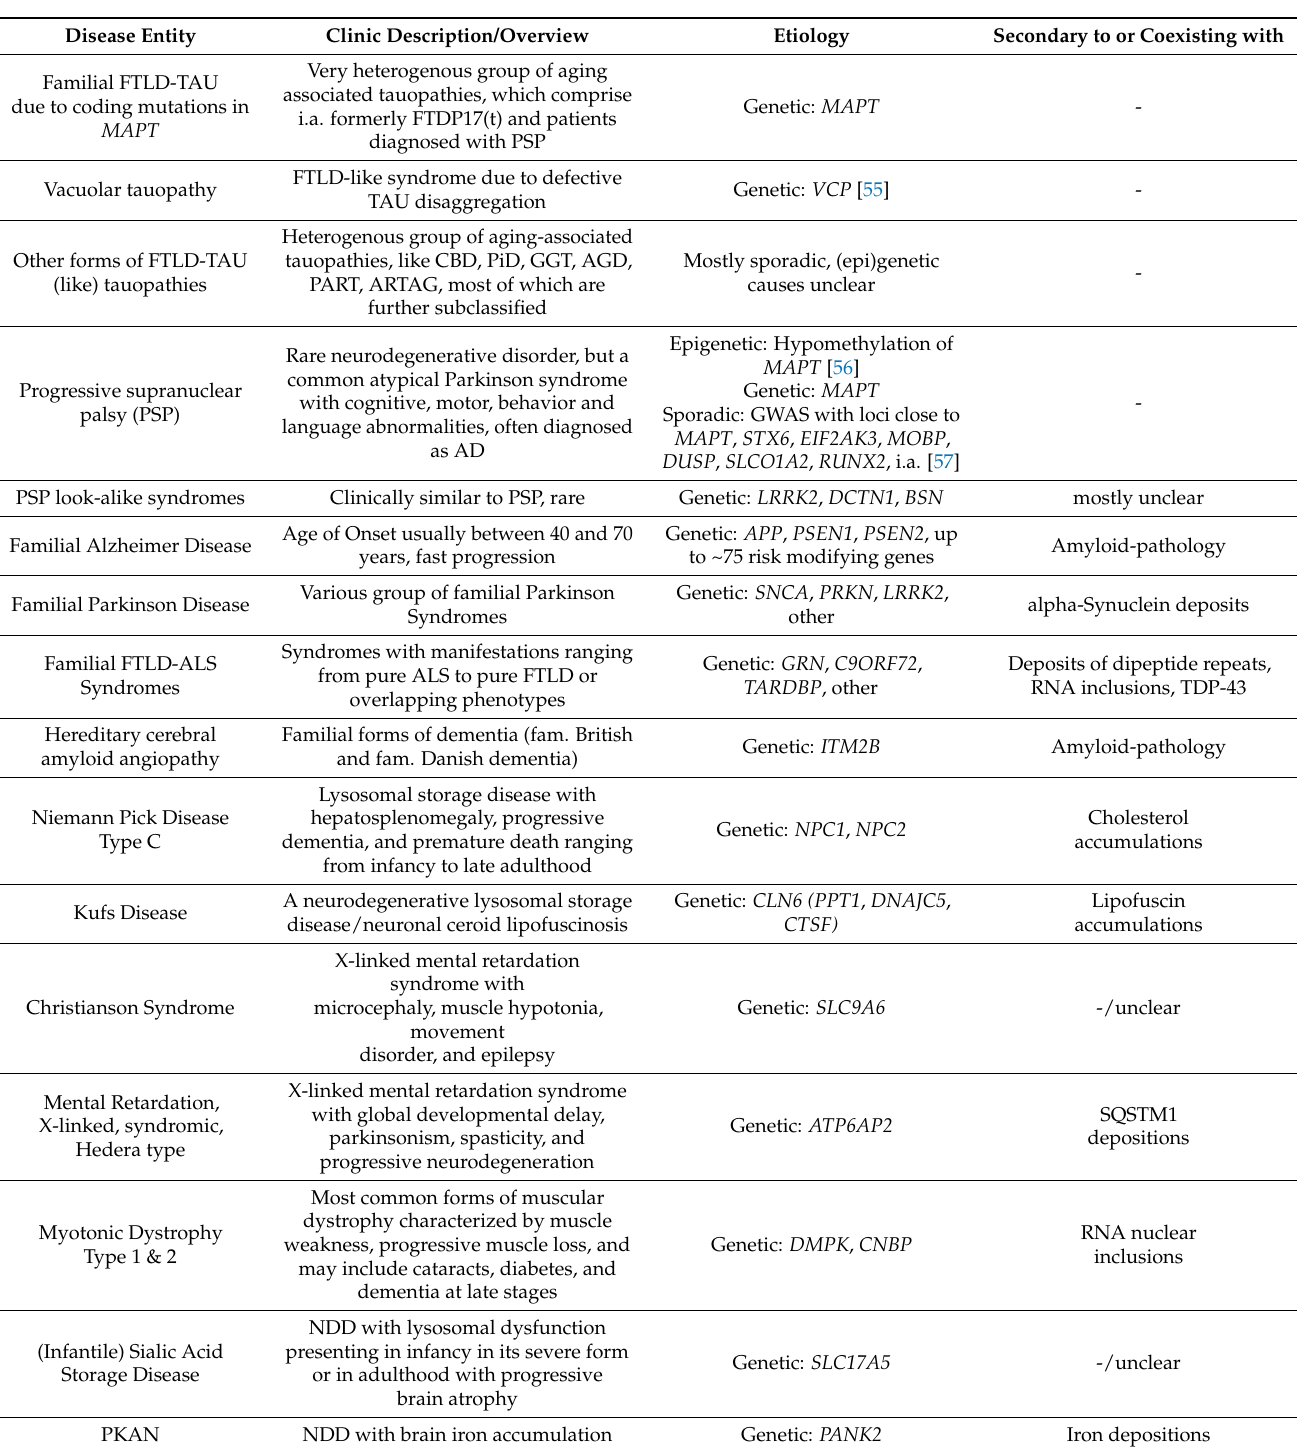
Table 1. Important examples of tauopathies with (epi)genetic etiologies or risk factors (see also [45,52–54]). Disease